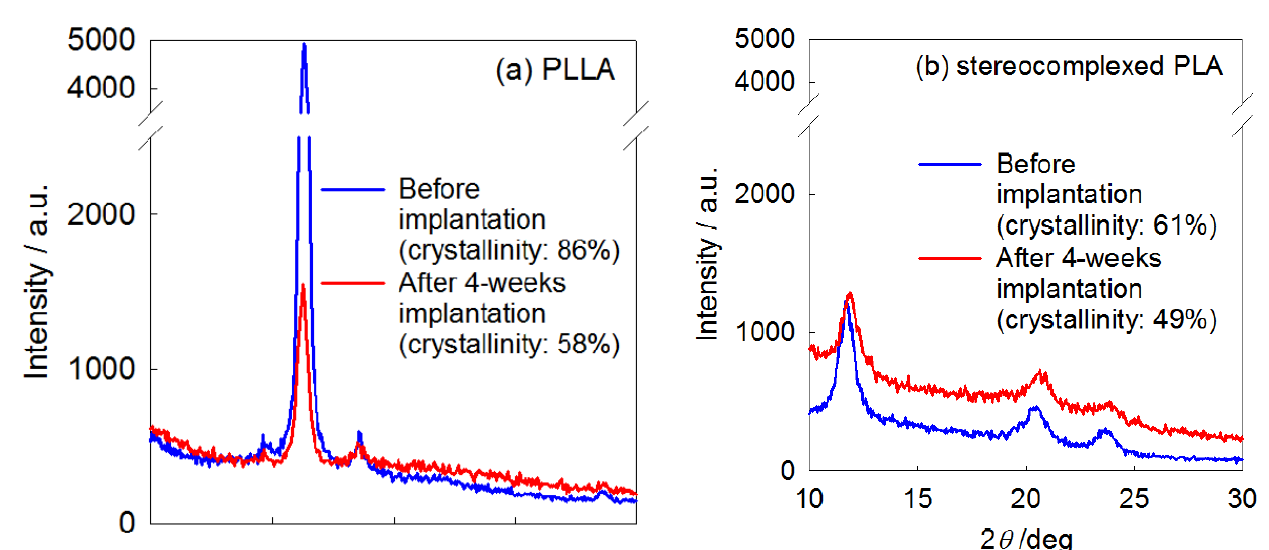
Figure 13. WAXD patterns of the PLLA and stereocomplexed PLA nanofibers before and after 4-weeks of implantation